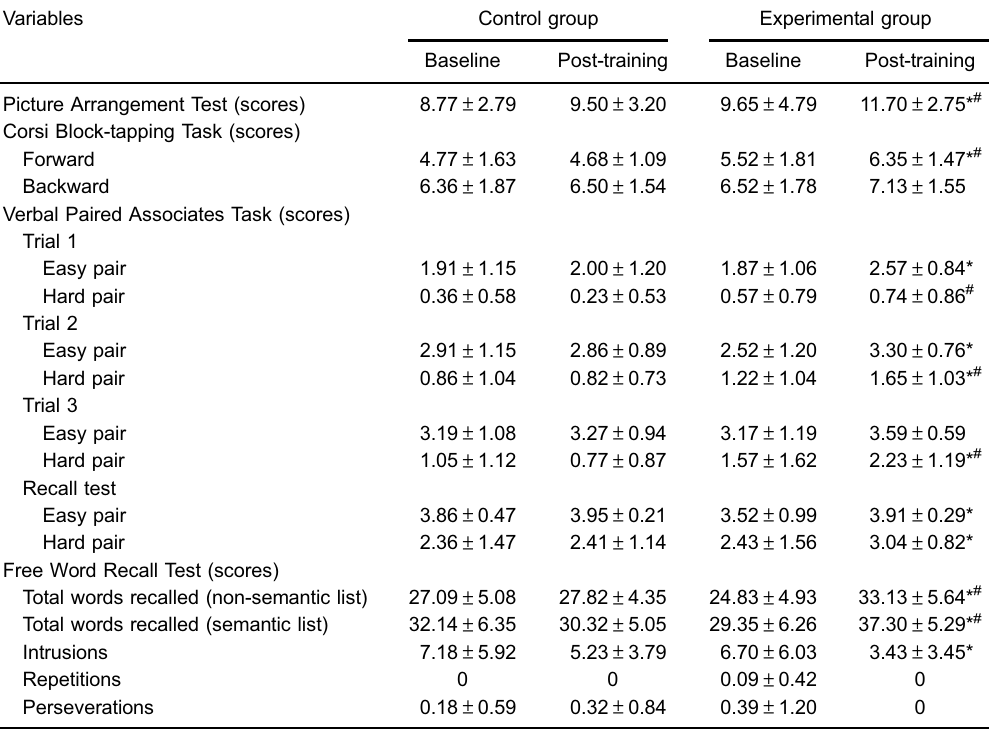
Table 1. Results of neuropsychological